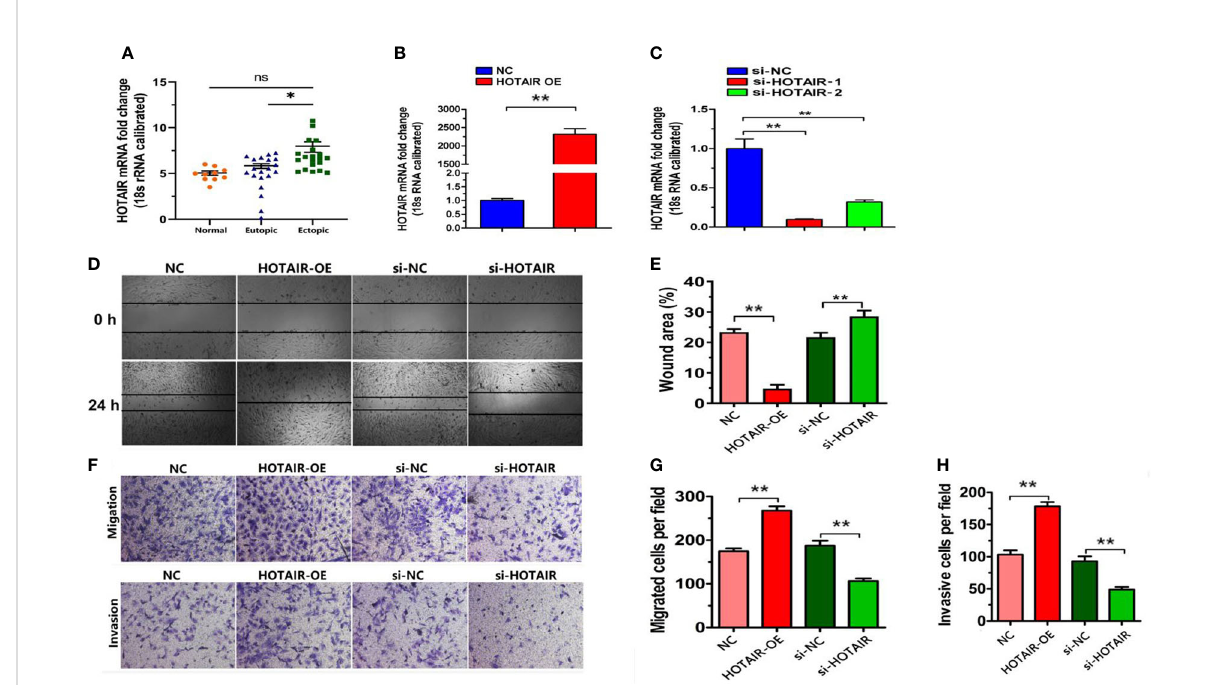
FIGURE 1 Relative expression of LncRNA HOTAIR in ectopic endometrial tissues and effect of LncRNA HOTAIR regulation on endometrial stromal cells. (A) Relative expression of LncRNA HOTAIR in ectopic endometrial tissues. 18s RNA was used as endogenous control. Normal, normal endometrial tissues of nonendometriosis patients; Eutopic, eutopic endometrial tissues of endometriosis patients; Ectopic, ectopic endometrial tissues of endometriosis patients. Data are presented as the mean ± SEM. *P < 0.05 vs. Normal; (B-H) , effect of LncRNA HOTAIR regulation on endometrial stromal cells. (B, C) LncRNA HOTAIR expression of different groups by RT-qPCR, (D, E) Cell scratch assays of the effect of overexpression LncRNA HOTAIR and si-HOTAIR on endometrial stromal cell migration, (F-H) Transwell assays of the effect of overexpression LncRNA HOTAIR and si-HOTAIR on endometrial stromal cell invasion and migration si-NC: negative control transfected cells; siHOTAIR: Knockdown of LncRNA HOTAIR transfected cells. NC: empty vector transfected cells; HOTAIR OE: overexpression of LncRNA HOTAIR transfected cells. Data are presented as the mean ± SEM, n=8 in each group. **P < 0.01 vs. NC or